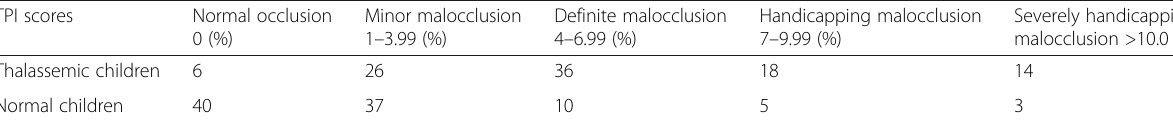
Table 3 Comparison of TPI scores in thalassemic and normal children TPI